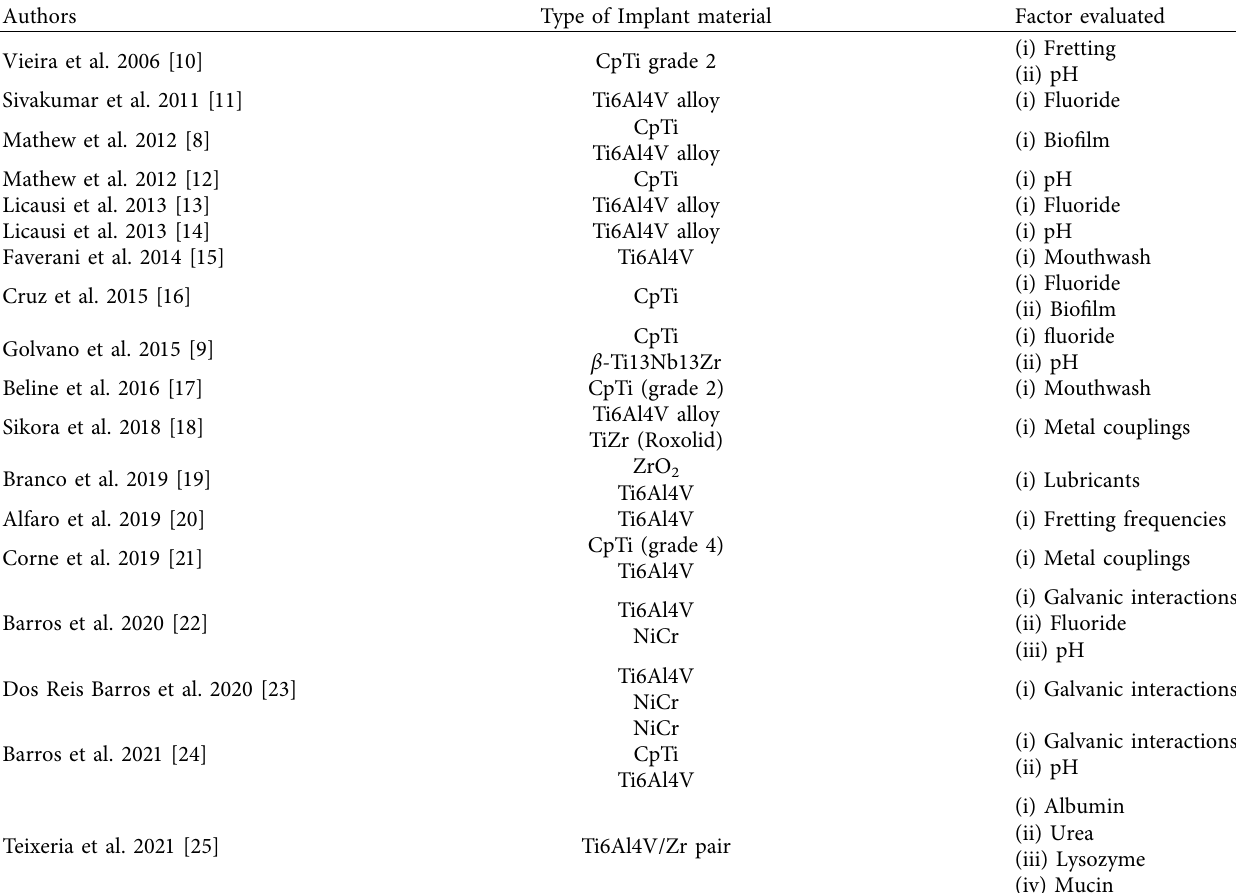
Table 1: Studies evaluating the factors responsible for bio-tribocorrosion of titanium dental